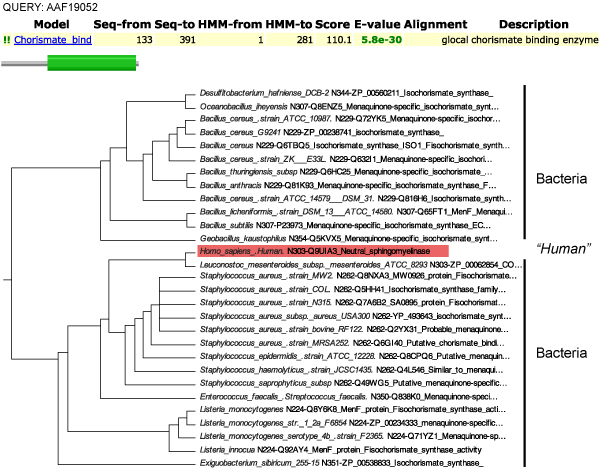
Human sphingomyelinase or bacterial isochorismate synthase? The sequence AAF19052 is reported to be a human neutral sphingomyelinase, containing a DEATH domain at the C-terminus. The top panel shows the PFAM domain architecture, which reveals the presence of a chorismate-binding domain at the C-terminus and the absence of a DEATH domain. The lower panel displays a structural phylogenomic analysis, resulting from clustering the sequence homologs to AAF19052 using FlowerPower and construction of a Maximum Parsimony tree. Examination of the phylogenetic tree suggests that AAF19052 (red box) is more likely an isochorismate synthase of bacterial origin. Each node in the tree is labeled with the species of origin, SCI-PHY subfamily label (see Methods), and sequence identifier and definition line.